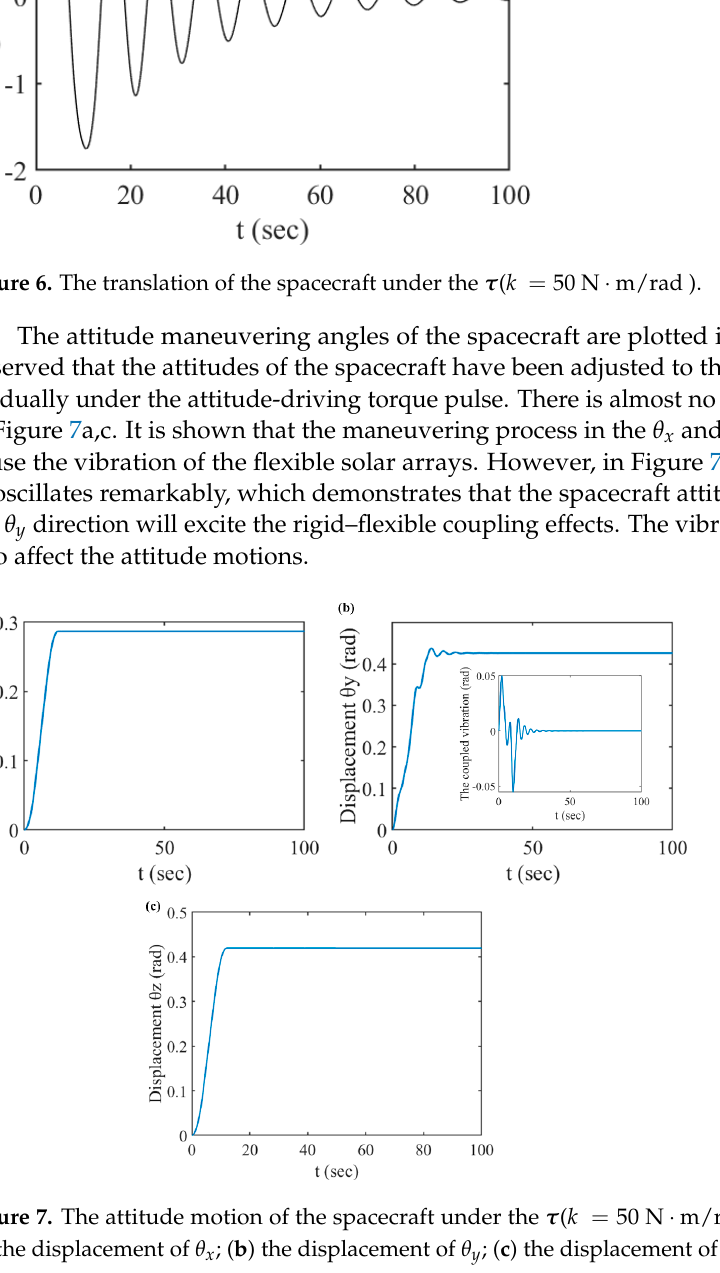
θ ; ( c ) the displacement of y